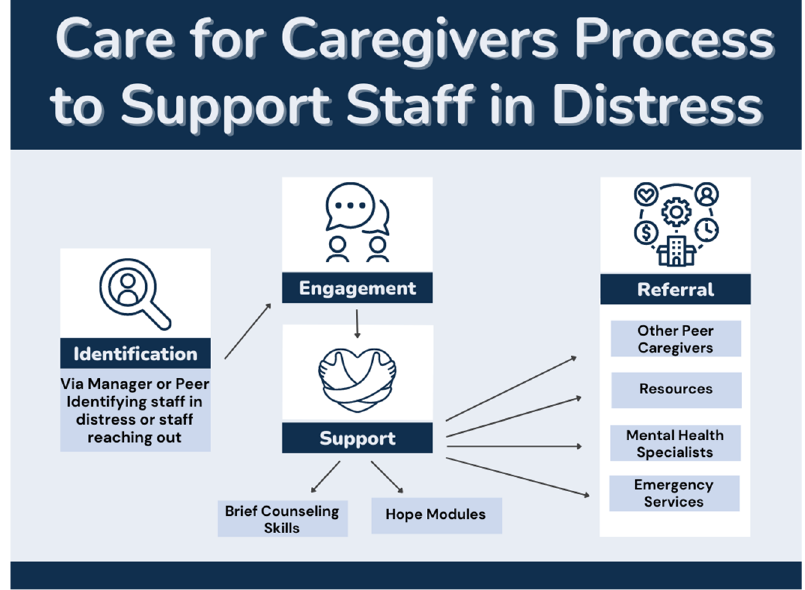
Figure 1. Care for Caregivers process to support staff in distress.